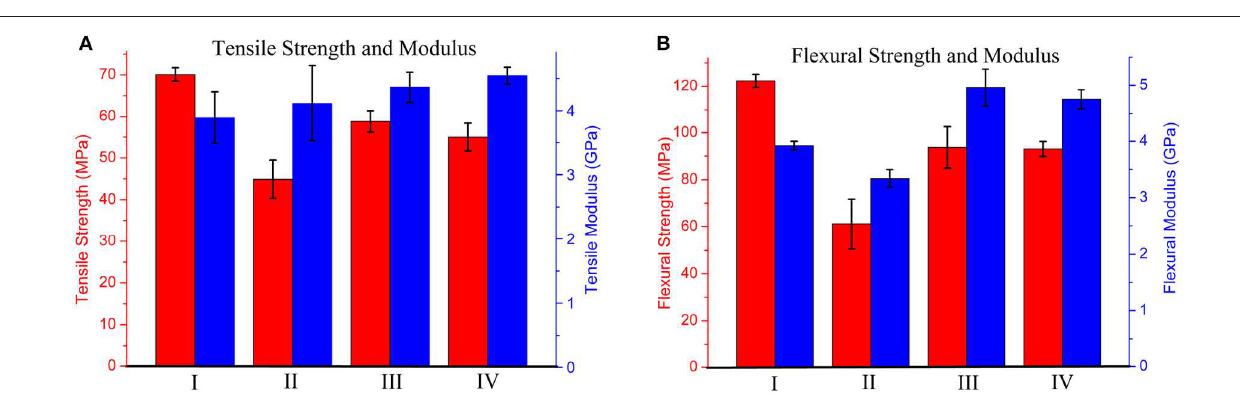
FIGURE 7 | ChF biocarbon composites (A) tensile strength and modulus, (B) flexural strength and modulus. Sample labels in the x axis are as follows: (I) Neat PLA, (II) 80/20 PLA/ biocarbon (300 ◦ C), (III) 80/20 PLA/biocarbon (600 ◦ C), (IV) 77/20/3 PLA/biocarbon/MA-g-PLA (600 ◦